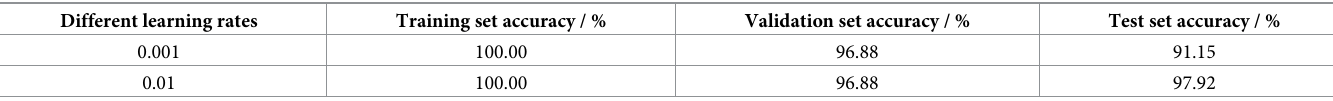
Table 3. Comparison of model accuracy rates at different learning rates.